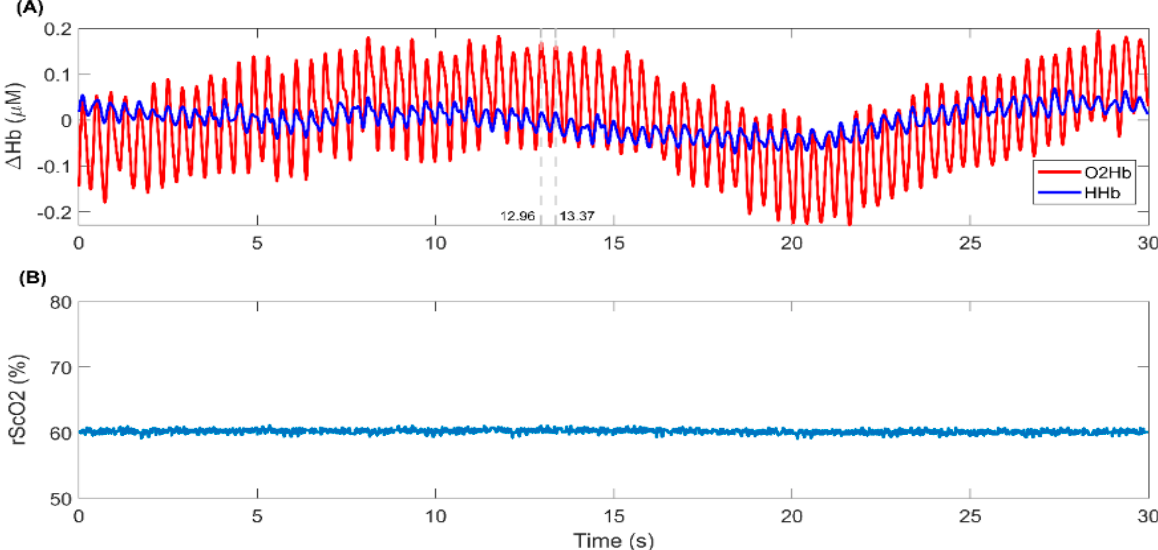
Figure 2. An example of the NIRS signals recorded by the TOM device (Artinis Medical Systems B.V., Elst, The Netherlands). ( A ) Concentration changes in oxygenated hemoglobin (O 2 Hb) and deoxygenated hemoglobin (HHb) in red and blue, respectively. These signals have been detrended to have a similar baseline. The heartbeats are visible in both signals as pulsatile changes with approximately 0.4-s time interval. ( B ) The cerebral tissue oxygenation, rScO 2 , computed by the TOM device in percentage. The signals are sampled at 100 Hz.